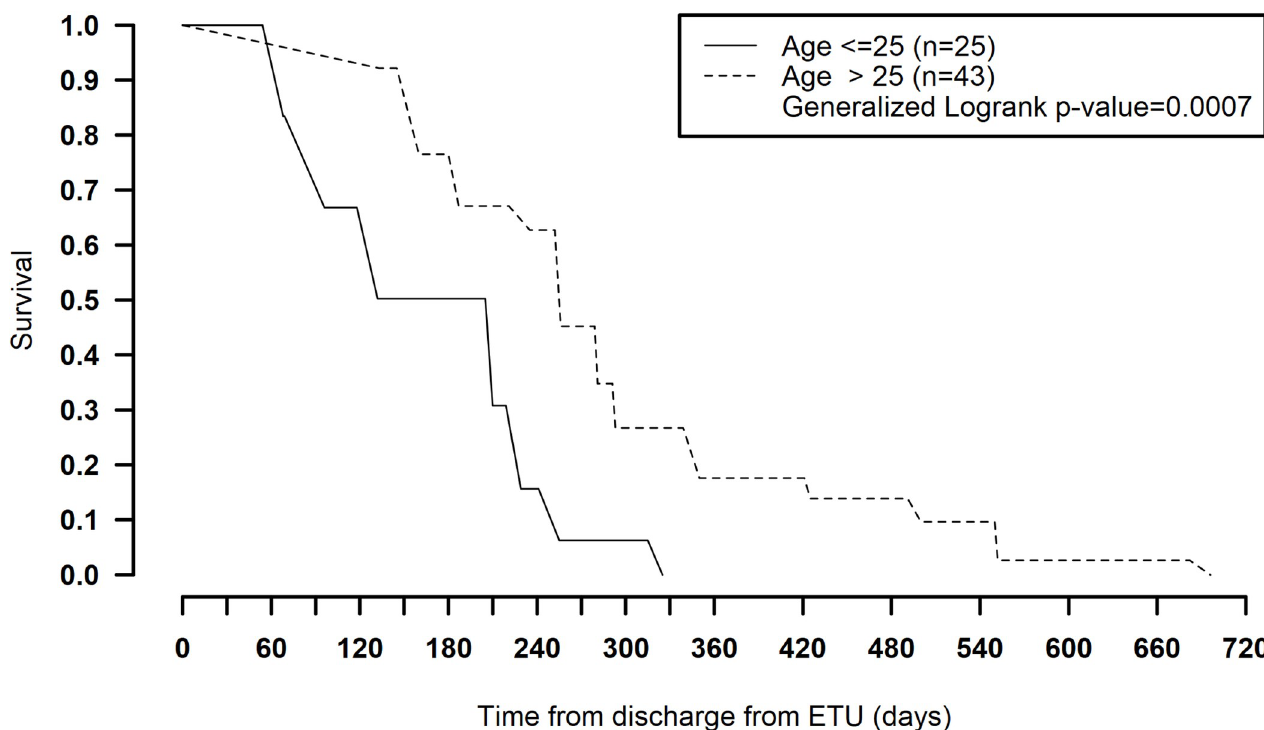
Fig 3. Survival function of Ebola virus RNA persistence over time (days) stratified by age, within the sub-population who had severe acute disease (ETU cycle threshold value < 27). ETU, Ebola treatment unit.